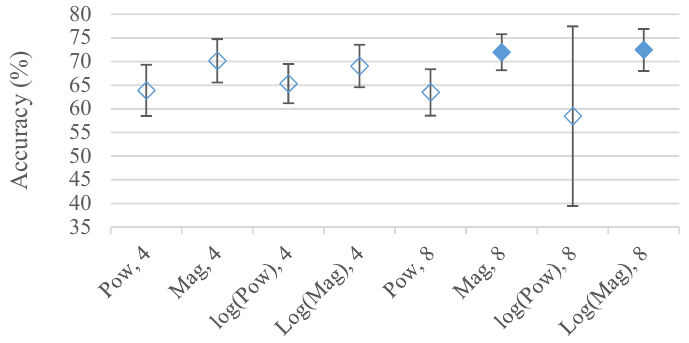
Figure 11. Averaged accuracies and standard deviations for different modifications of spectral magnitudes: magnitude (Mag), power (Pow), log magnitude, and log power, for 4 and 8 kHz maximal frequencies. Filled marks show equally performing